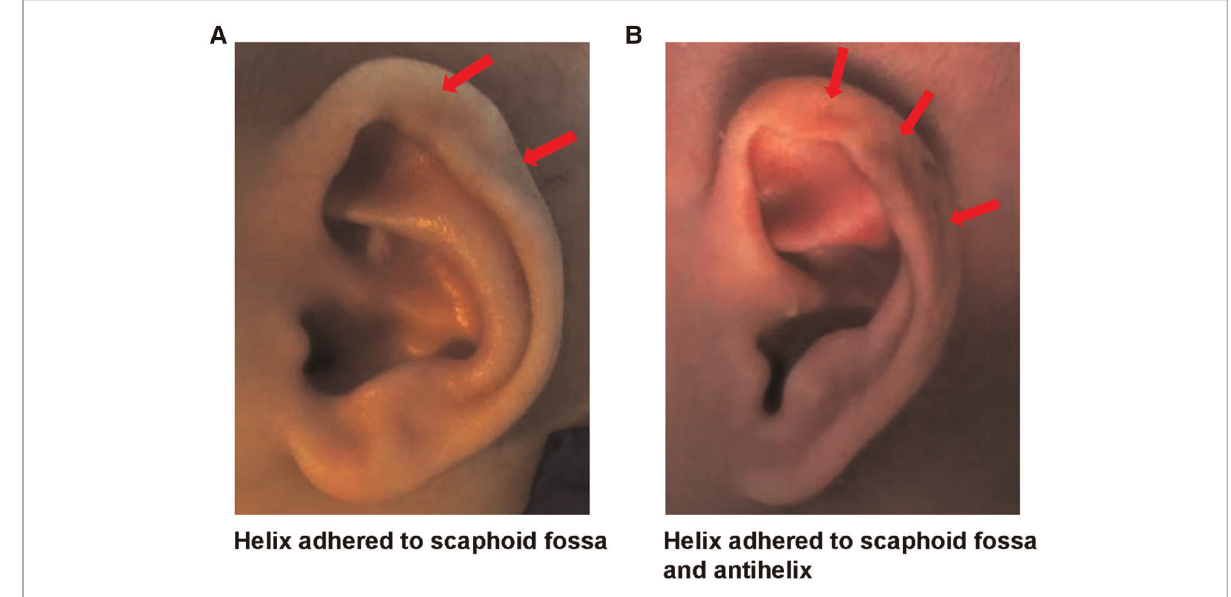
FIGURE 1 Auricular adhesion